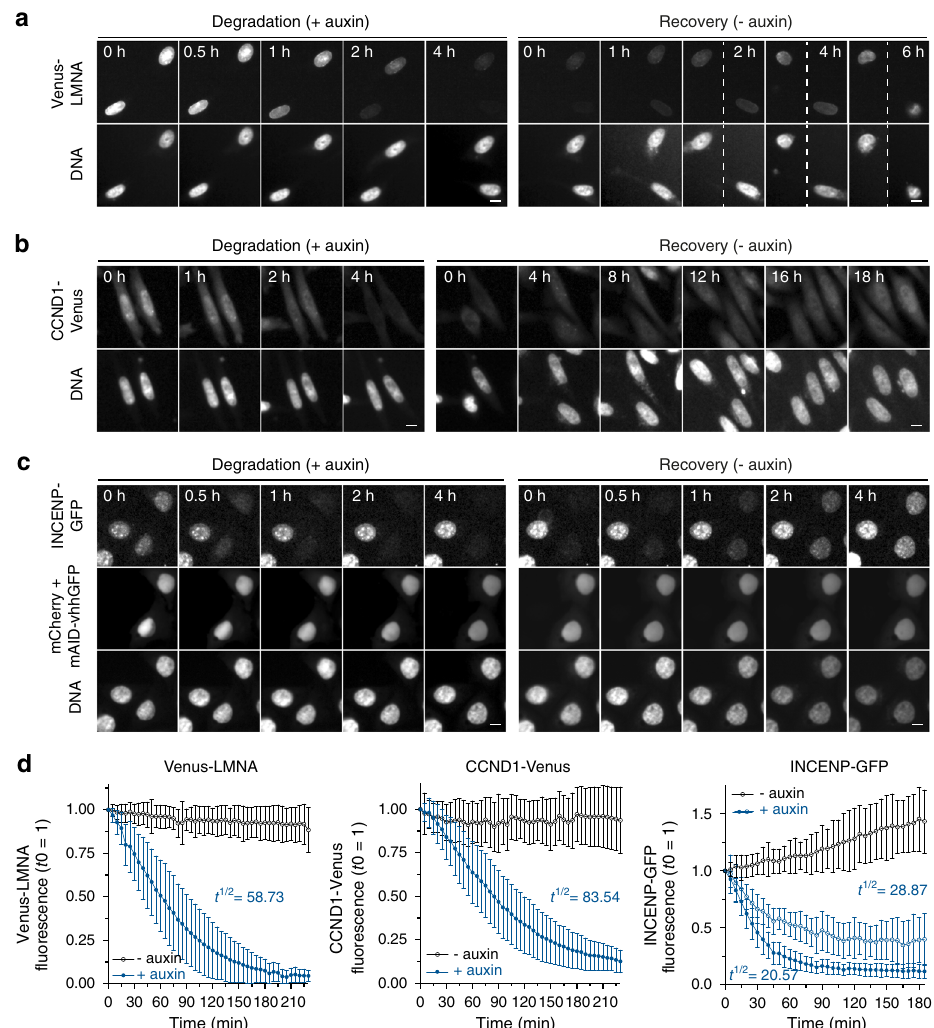
Fig. 3 Conditional and reversible depletion of GFP-fusion proteins localized to distinct cellular compartments and structures by mAID-nanobodies. a Time- lapse images showing the degradation and recovery of ( a ) nuclear lamina-associated Venus-LMNA and b nuclear and cytoplasmic CCND1-Venus in Hela cell lines expressing tetracycline-inducible mAID-nanobody or c the centromere-associated Inner centromere protein (INCENP-GFP) after transient transfection of mAID-nanobody and nuclear mCherry expressed from the same mRNA (mCherry + mAID-VHH, see Methods). a – c Degradation and recovery were induced by the addition or removal of 0.5 mM auxin for the indicated time. Scale bar: 10 μ m. d Single cell degradation kinetics of Venus- LMNA, CCND1-Venus and INCENP-GFP from the experiments shown in a – c . Open blue circles indicate degradation INCENP-GFP cells that reach a plateau at ~50% of the initial fl uorescence. Quanti fi cations show the mean ± s.d. Venus-LMNA and CCND1-Venus ( n = 40, – auxin; n = 40, + auxin). INCENP-GFP ( n = 14, – auxin; n = 29, + auxin (plateau); n = 40, +